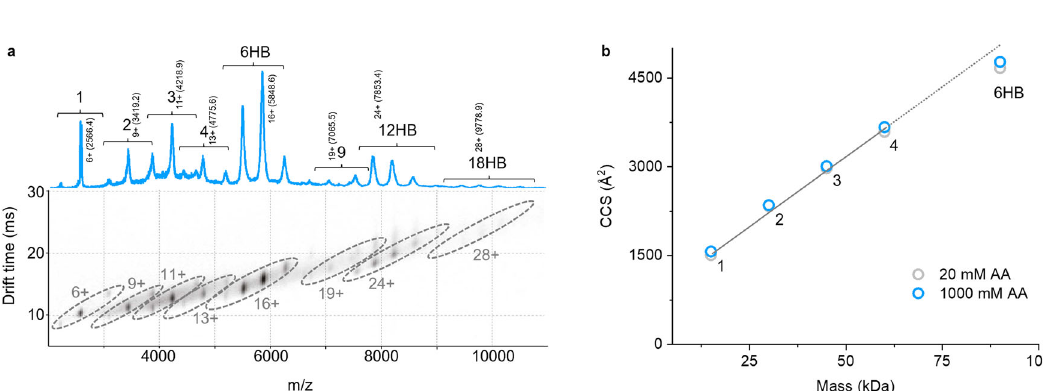
Fig. 3 Ion mobility-mass spectrometry (IM-MS) analysis of nanostructure assembly at 300 mM AmAc. Experimental parameters: sampling cone 125 V, trap collision energy 25 V, trap DC bias 50 V, trap pressure 4.38 × 10 − 2 mbar, and backing pressure 5.88 mbar. a Top panel: native ESI-MS showing oligomers up to 18-mer (18HB). Bottom panel: corresponding drift time plot with different charge states (selected peaks annotated) of the same oligomer size grouped into ellipses. b Collision cross sections (CCS) derived from the measured IM drift times for different oligomer sizes after calibration, using the charge state with the highest peak intensity per group: (monomer (1) 6 + , dimer (2) 9 + , trimer (3) 11 + , tetramer (4) 13 + and (6HB) 16 + ), at AmAc concentrations of 20 and 1000 mM. Monomer (1) to tetramer (4) shows a near-linear size increase, whilst the hexamer (6HB) is below the linear trend line (dotted), and therefore more compact. Note that the pentamer (5) was not detected. Table 1 Experimental and calculated collision cross sections (Å 2 ) representing the cylindrical 6-mer nanostructure (6HB) as well as suggested 12HB and 18HB models (Fig.